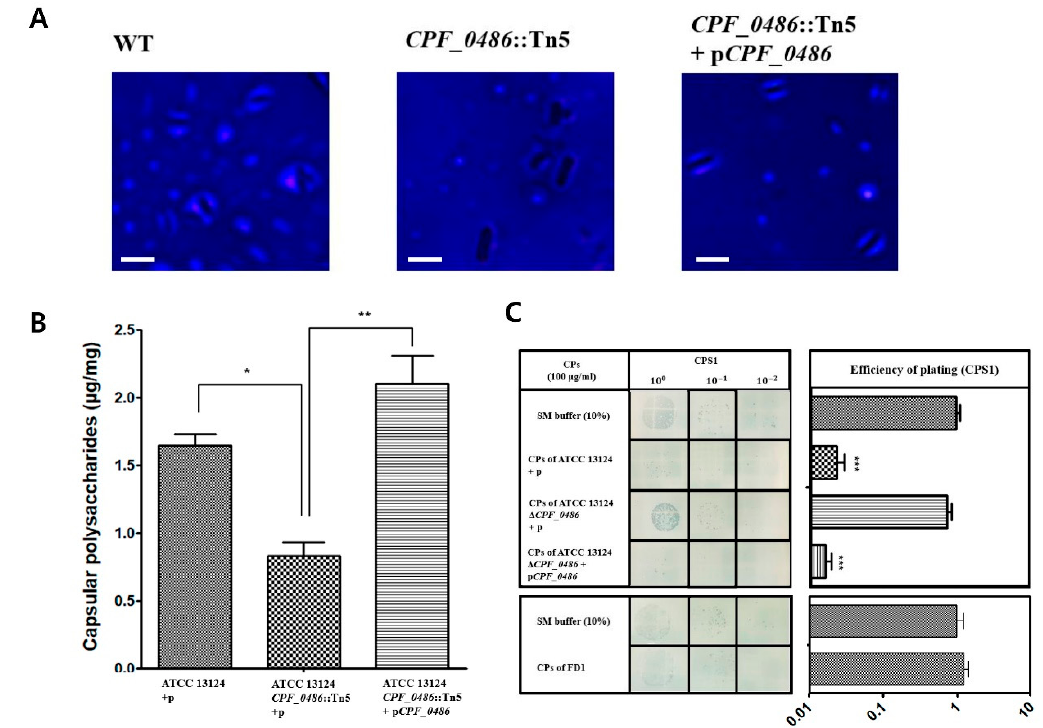
Figure 5. Capsular polysaccharides (CPS) are receptors of CPS1. ( A ) Capsule staining of wild type, CPF_0486 ::Tn5 mutant and complementary strain. The scale bars represent 1 µ m. ( B ) Quantification of CPS using a modified phenol sulfuric acid assay. ( C ) Measuring efficiency of plating (E.O.P.) of CPS1 which was preincubated with CPS. Top: CPS of C. perfringens ATCC 13124; bottom: CPS of C. perfringens FD1. The means with standard deviations ( A – C ) of triplicate experiments are shown. * P < 0.05, ** P < 0.01, *** P < 0.0001.